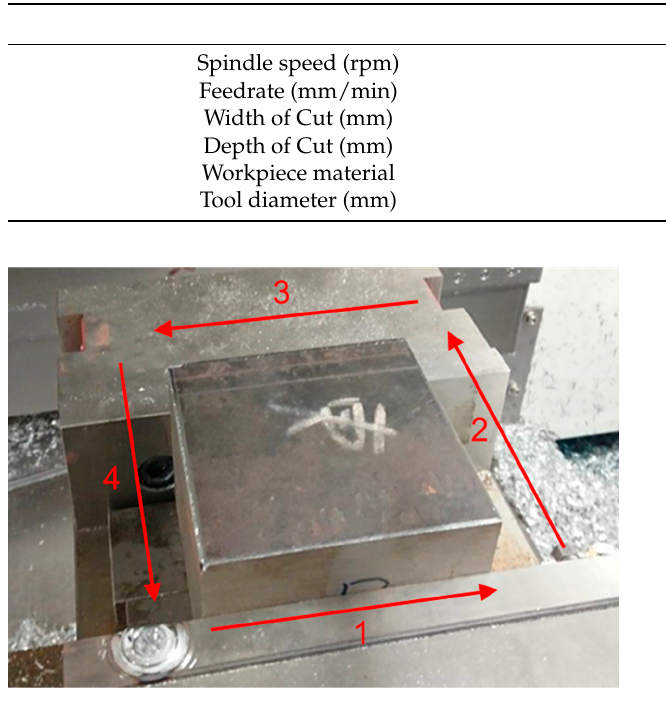
Figure 11. The sequence of cutting path for experiment 4 without empty groove.